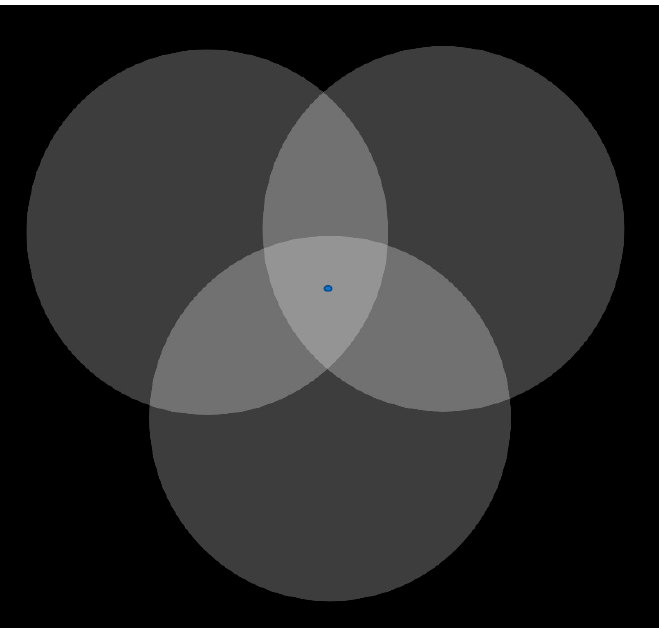
Figure 1. Attentional allocation modulates the perceived saliency and brightness of visual objects. Fixate your gaze on the central blue dot while directing your attention to one of the three overlapping circles. Whichever circle you focus your attention on will appear brighter than the other two (unattended) circles, and it will also seem to be positioned in front of them. Modified from